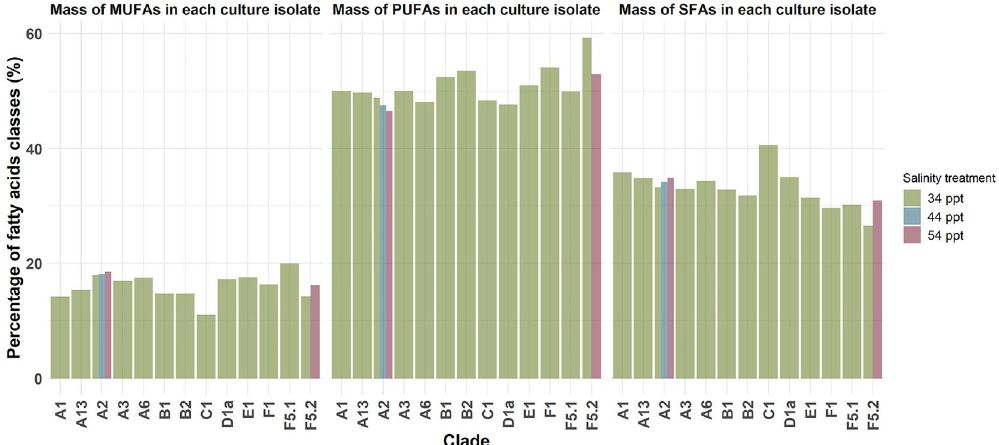
Figure 3. A histogram showing the percentage of the three different fatty acids classes among the culture isolates at 34 ppt (normal salinity) and increased salinities of 44 ppt and 54 ppt for the best performing isolates during cryopreservation. MUFA monounsaturated fatty acids, SFA saturated fatty acids, PUFA polyunsaturated fatty acids, Ppt parts per thousand.